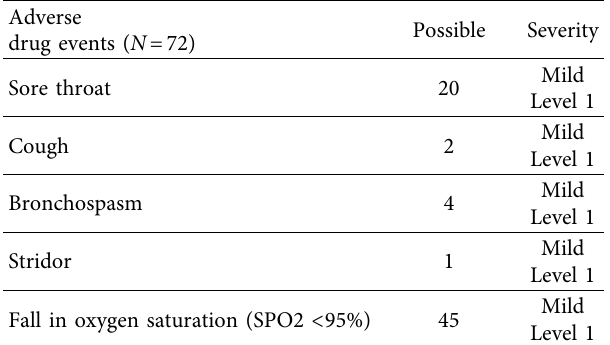
Table 4: Causality and severity assessment of adverse drug re- actions using the Naranjo probability scale and the Modifed Hartwig and Siegel Severity scale [10,